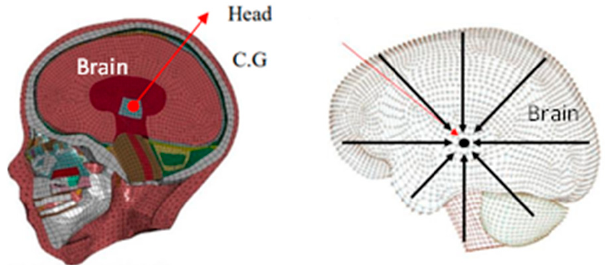
Figure 2. A 6-year-old child human body head model with the location of C.G. Figure 2. A 6 ‐ year ‐ old child human body head model with the location of C.G.